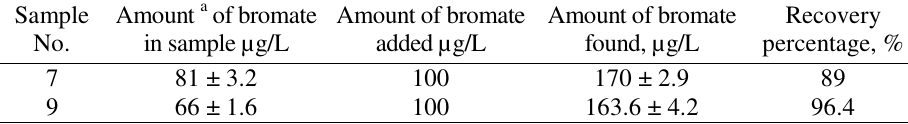
Table 6. Recovery of bromate from spiked bottled water